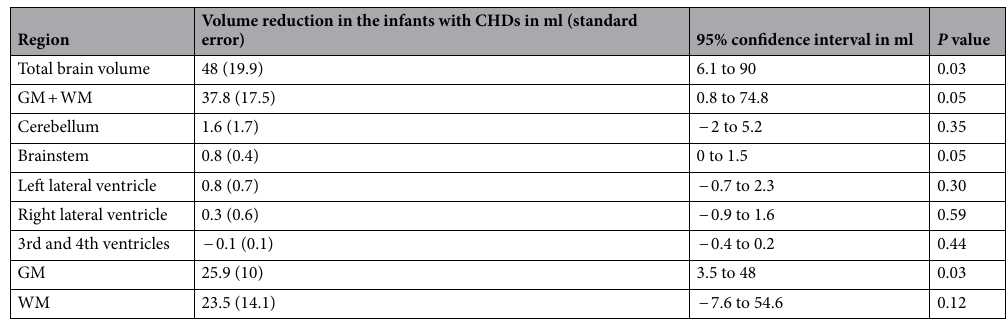
Table 3. Global and regional differences between those with(n = 10) and those without CHDs(n = 10). Cerebral grey matter (GM), cerebral white matter (WM), milliliters (ml).